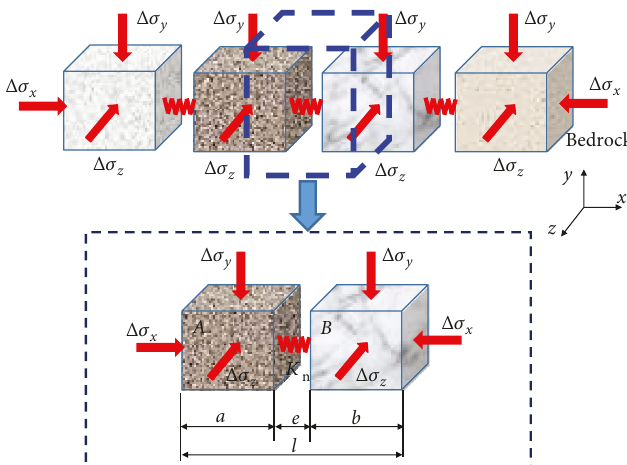
Figure 10: Displacement calculation model of heterogeneous rock mass with single fi ssure under three-direction stress condition.